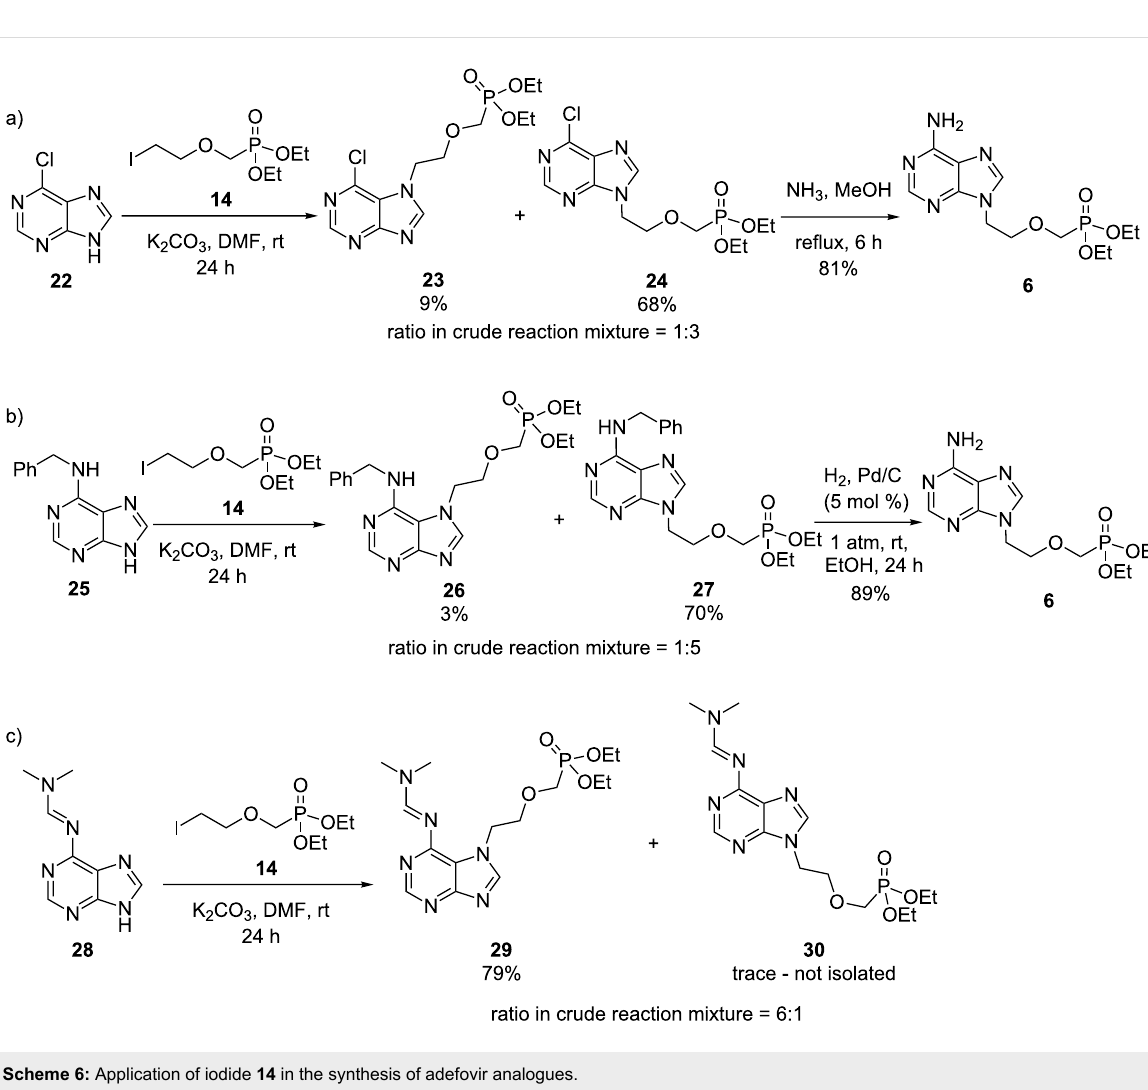
Scheme 6: Application of iodide 14 in the synthesis of adefovir analogues.